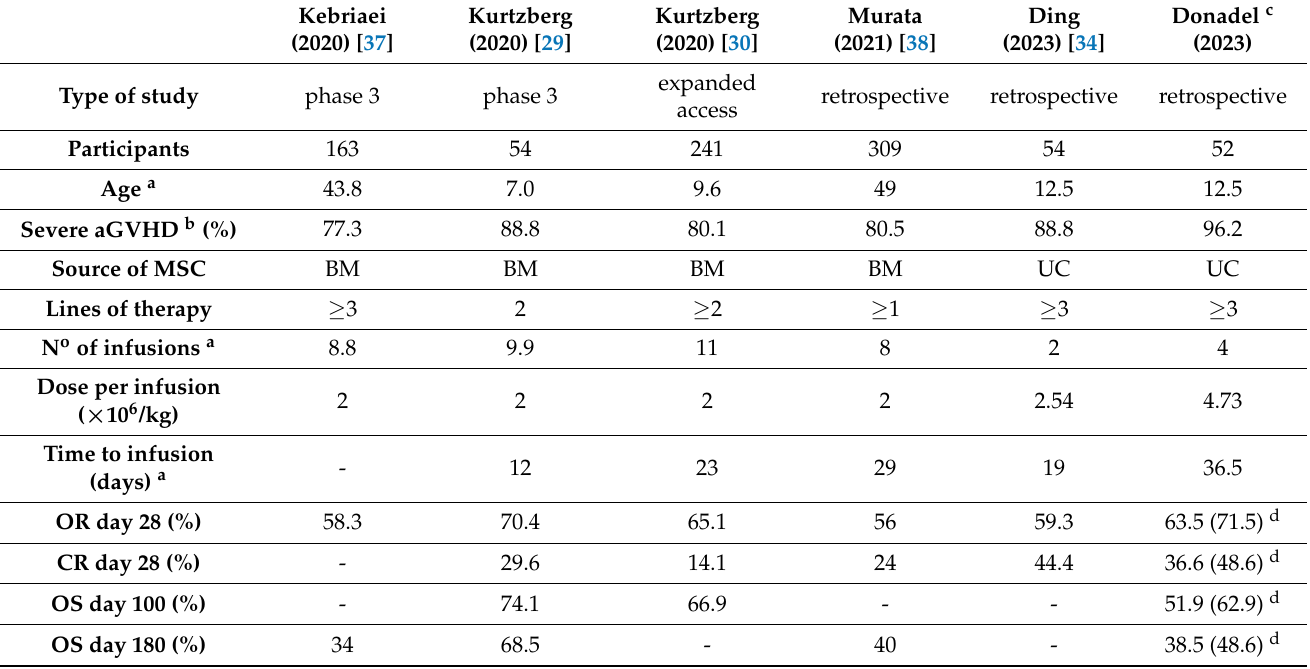
Table 4. Recent studies that evaluated the use of MSC in steroid-refractory acute graft-vs-host disease.